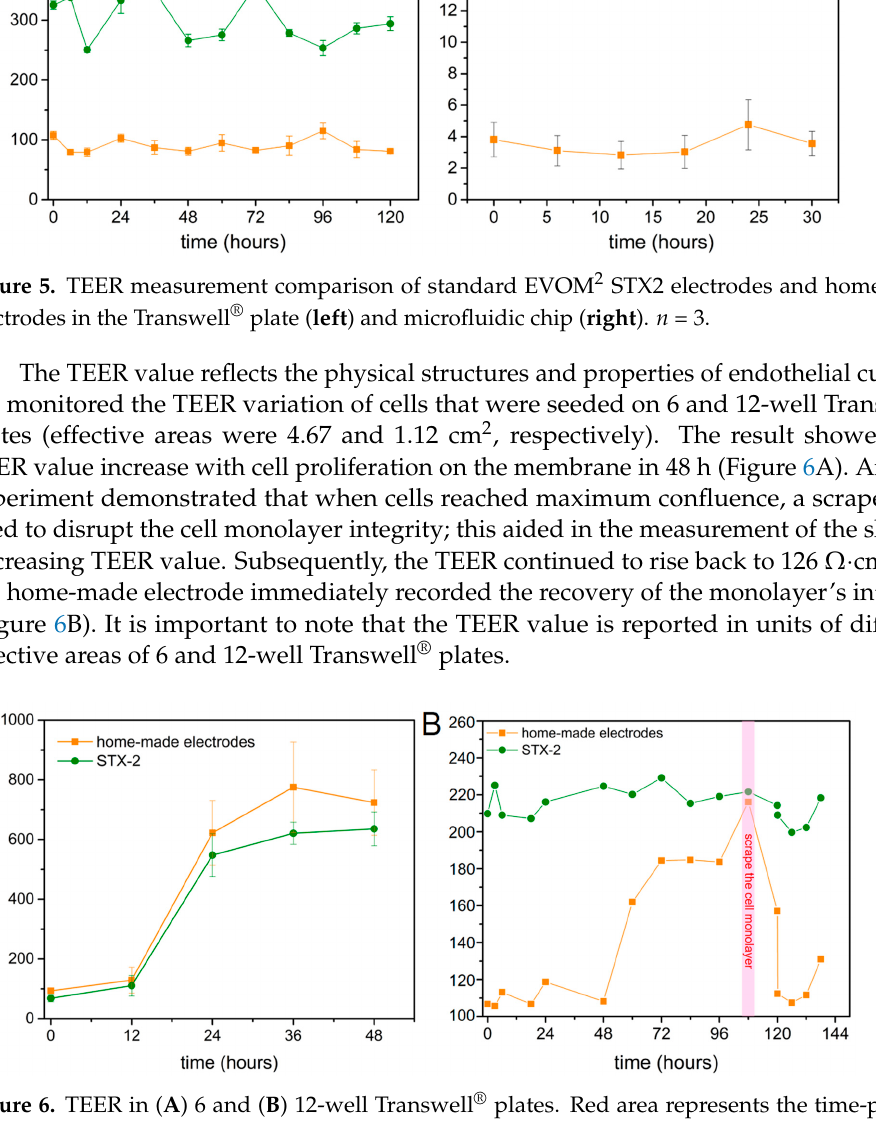
Figure 6. TEER in ( A ) 6 and ( B ) 12 ‐ well Transwell ® plates. Red area represents the time ‐ point at which cell monolayers were physically